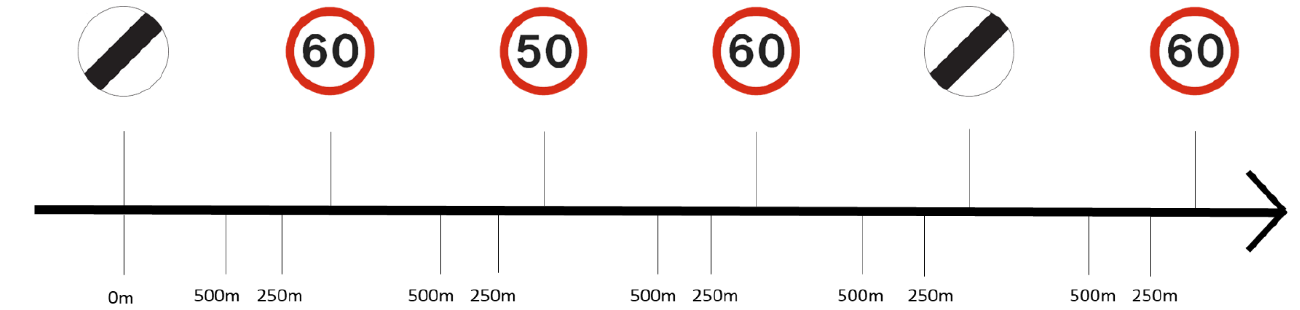
Figure 2. Position and order of overhead gantry’s speed limits in the noHMI baseline condition. The white circle crossed by a diagonal line is the National Speed Limit sign, which is 70 mph.